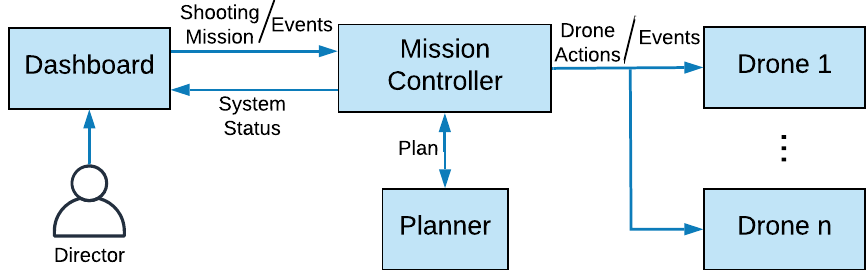
Figure 1. General scheme of the system architecture. The director defines shooting missions with the Dashboard and sends them to the Mission Controller. This Mission Controller uses a Planner to compute plans that are then sent to the drones. During the execution of the plan, the Mission Controller sends events to the drones to trigger actions and reports periodically to the Dashboard about the execution/system